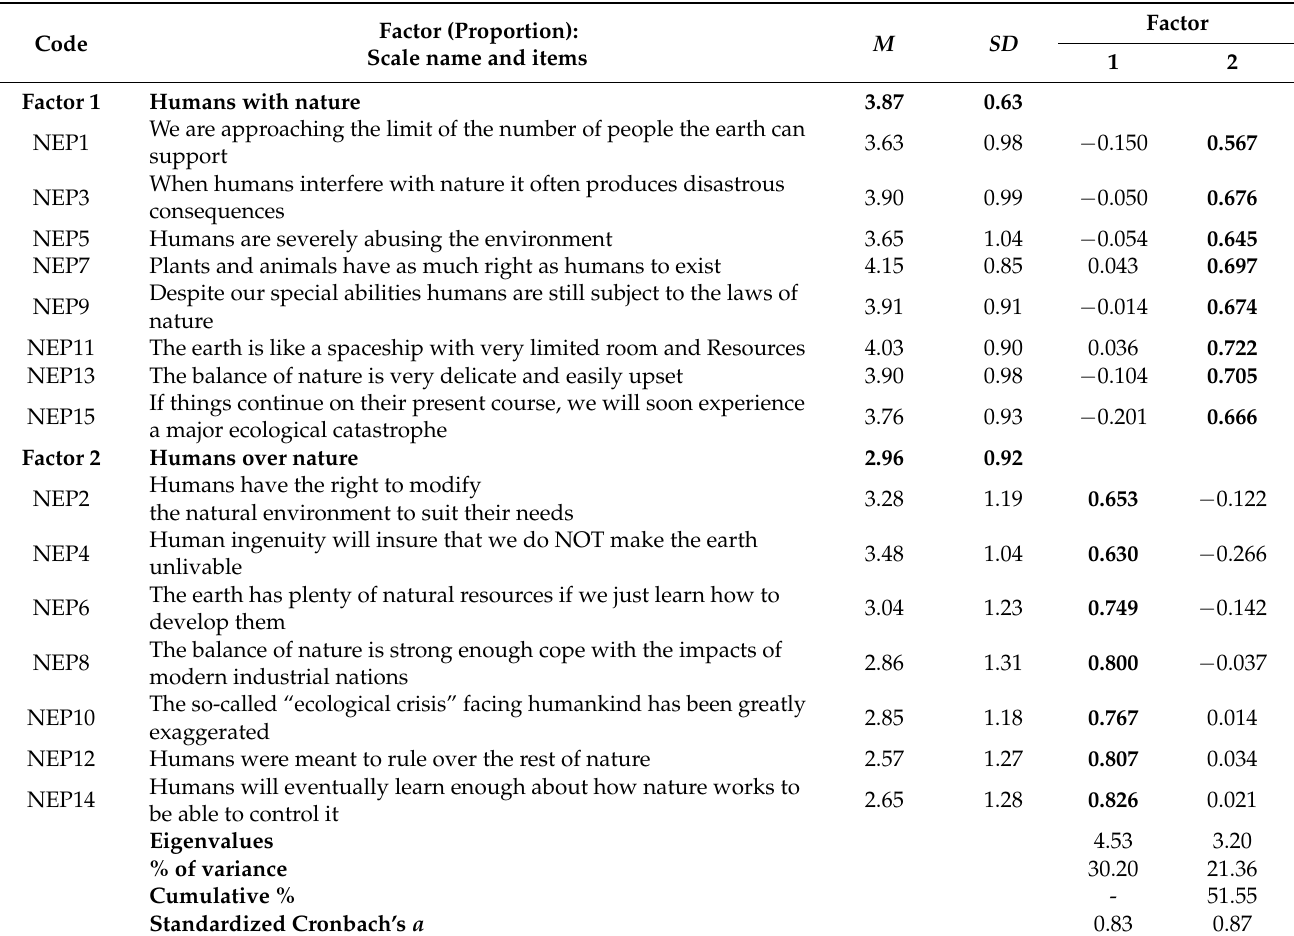
Table A4. Summary results of exploratory factor analysis for New Ecological Paradigm ( n = 595, 2021 sample).